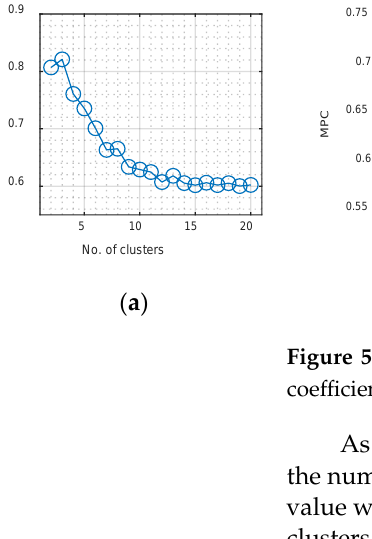
( e ) Figure 6. Cluster centers for the load and generation scenarios: ( a ) residential load; ( b ) commercial load; ( c ) industrial load; ( d ) PV generation; and ( e ) wind generation. 5. Discussion on Restoration Results